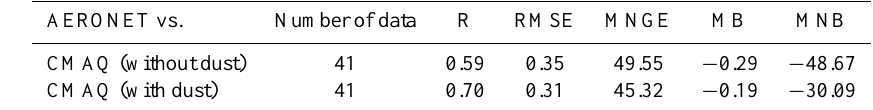
Table 3. Statistical values between the CMAQ-simulated and AERONET AODs in spring, 2006. AERONET vs.